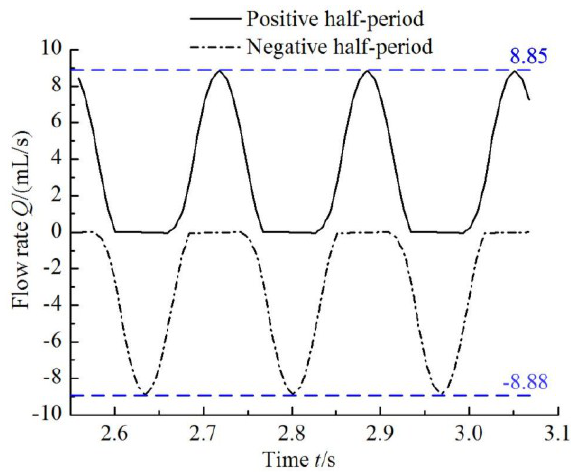
Figure 10. Transient flow rate curves of branches of outlet